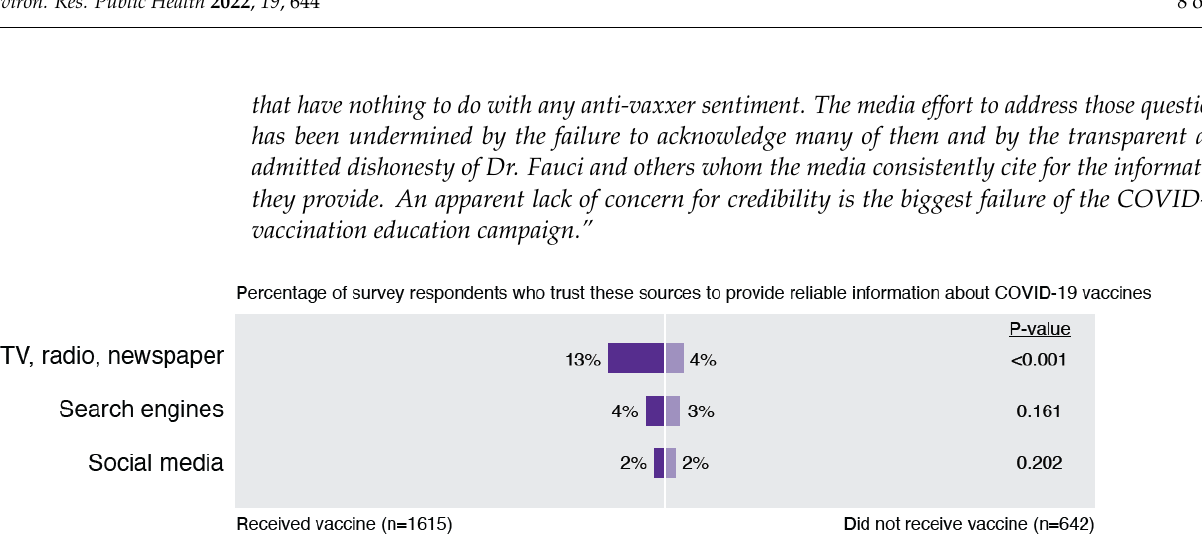
Figure 5. Differences in trust in media between vaccinated and unvaccinated EMS professionals.